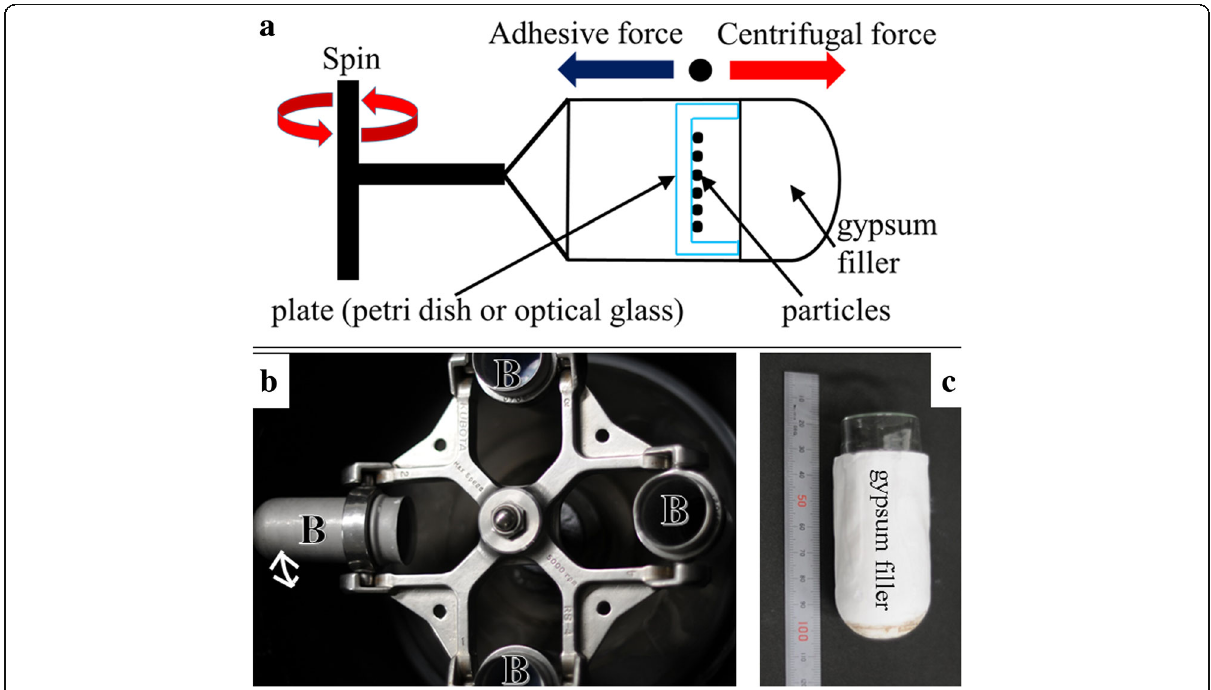
Fig. 3 a Schematic diagram of the experimental configuration used for the adhesive force measurements. b Image inside the centrifuge. There are four baskets (marked “ B ” ), each of which can be tilted freely from vertical to horizontal. c Image inside the basket. A Petri dish of